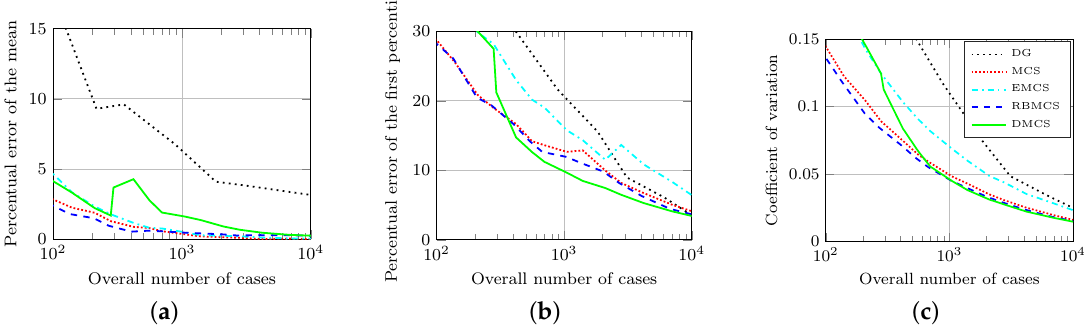
Figure 8. Convergence of the five sampling concepts using measurement data of H05. ( a )Lifetime mean value errors ( ∆ µ ). ( b )Lifetime 1% error ( ∆ L 1 ). ( c )Lifetime coefficient of variation ( CV ).